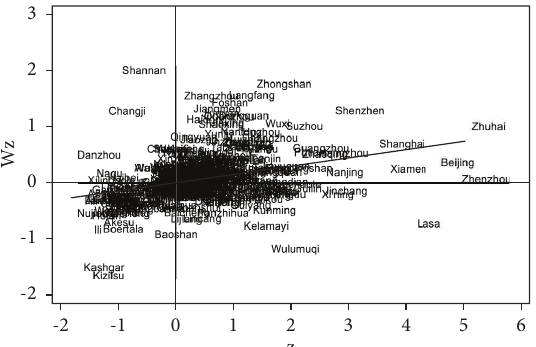
Figure 2: Moran’s I in spatial clustering of digital economy in